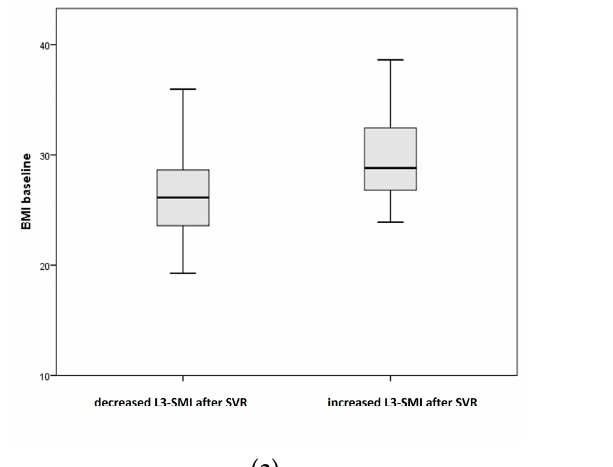
Figure 2. Boxplot for BMI ( a ) and ALT ( b ) values for patients with decreased L3-SMI and patients with increased L3-SMI after SVR.